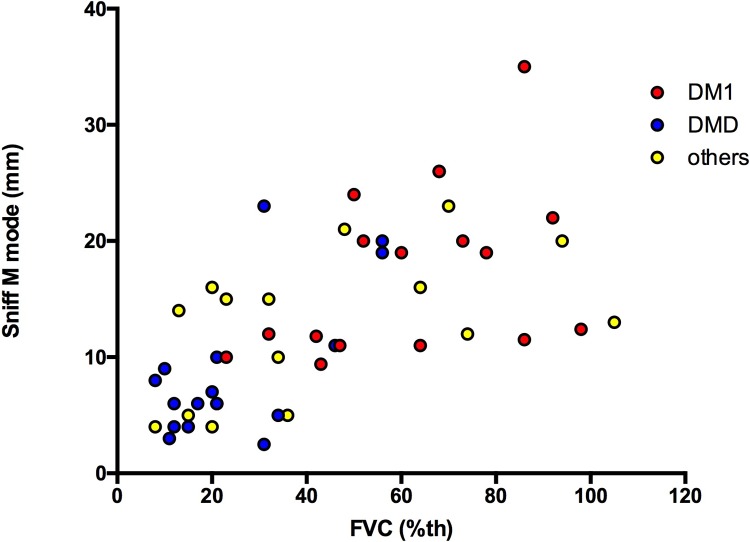
Relationship between right sniff diaphragm TM motion and FVC in DMD.DM1 and other myopathies. DMD = Duchenne muscular dystrophy; DM1 = myotonic dystrophy type I; others = other myopathies; FVC = forced vital capacity (%); sniff M mode = right sniff diaphragm time movement motion (mm).